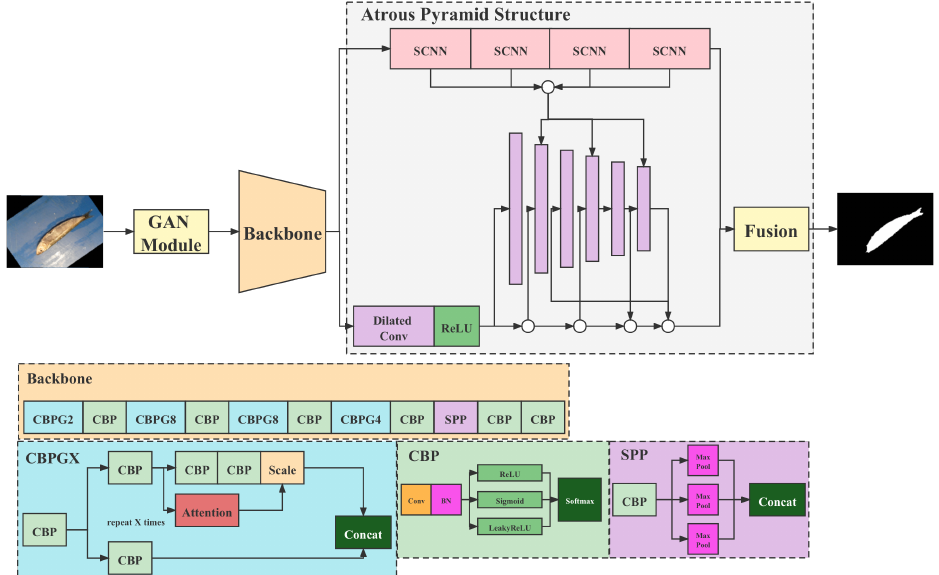
Figure 5. Structure of the atrous pyramid GAN segmentation